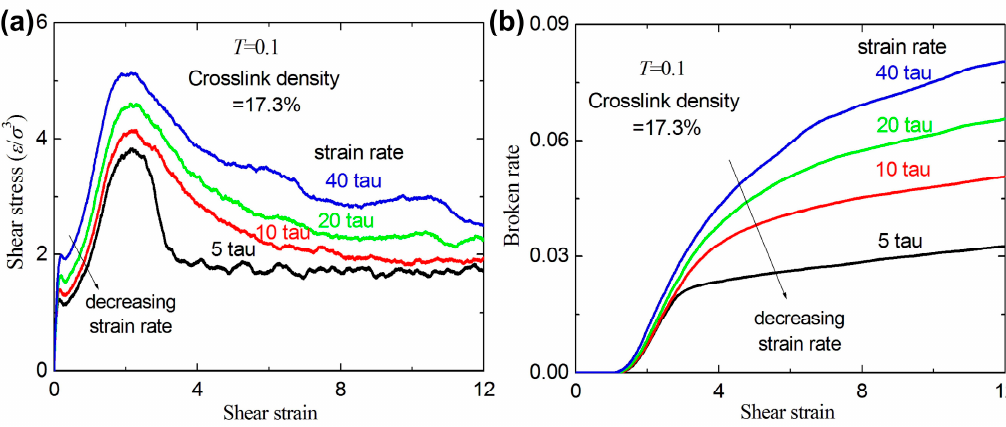
Figure 10. ( a ) The tensile stress ‐ strain curves with different strain rates for a given crosslink density of 17.3%; and ( b ) the broken ratio versus strain rate.